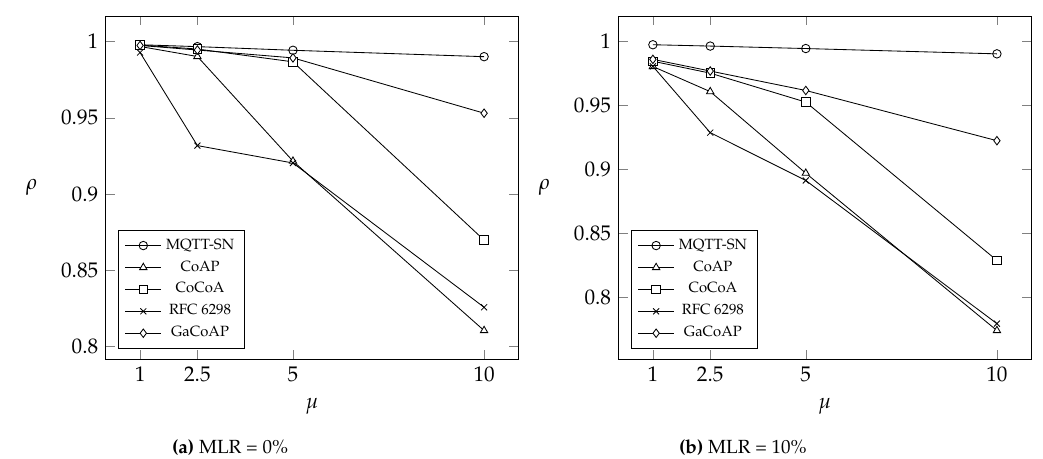
Figure 5. The average number of retransmissions δ under different µ .